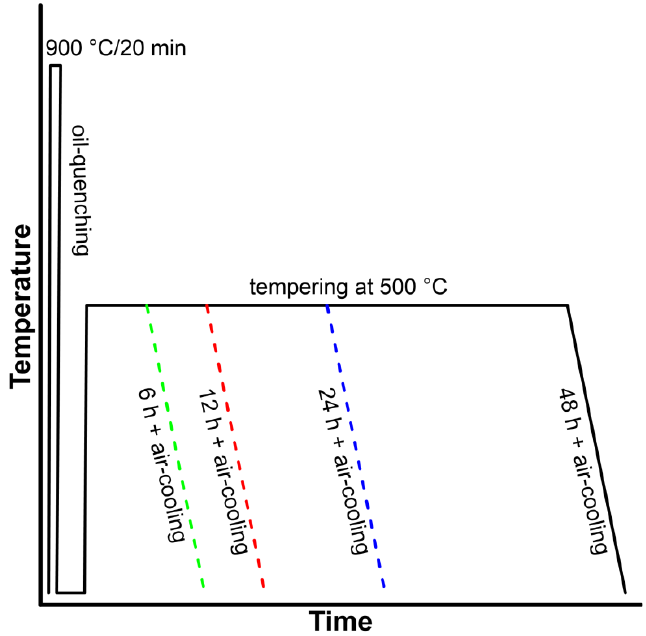
Figure 1. Schematic illustration of the heat treatment.